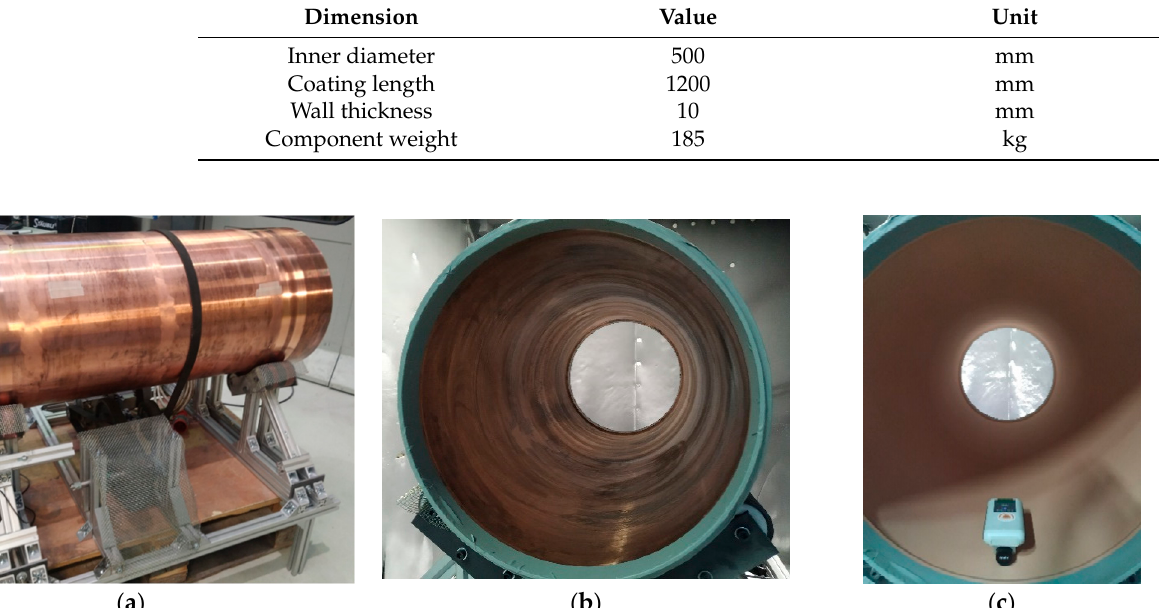
Figure 4. Tube prior to coating operation, mounted on a rotational support specially constructed for this purpose ( a ). Before sand blasting ( b ) and after ( c ).